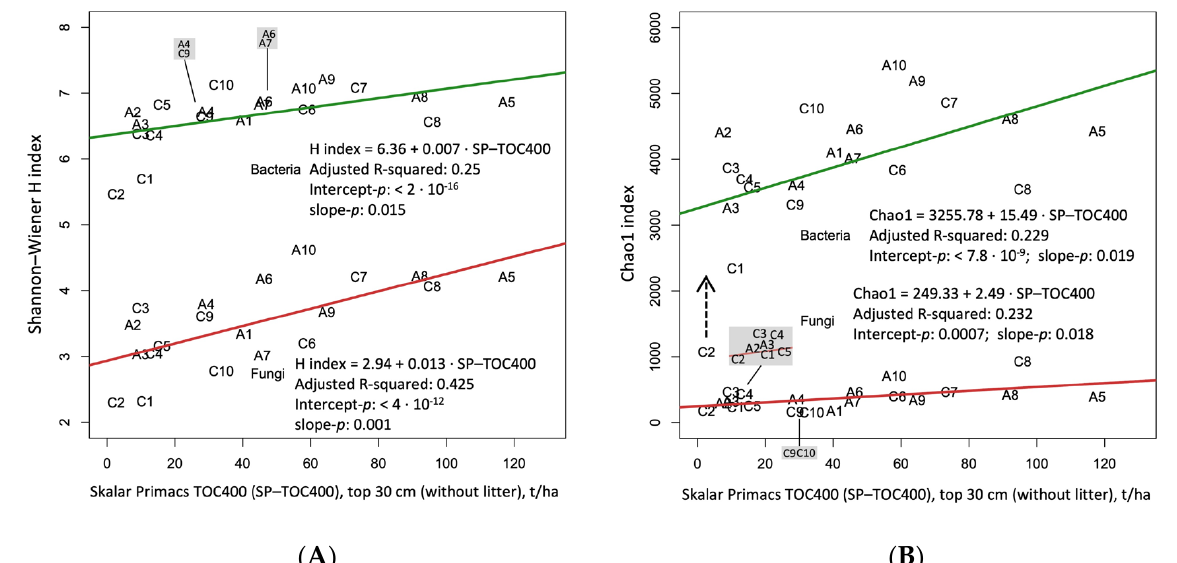
Figure 11. Linear regressions between ( A ) Shannon–Wiener or ( B ) Chao1 indices (OTUs of bacteria